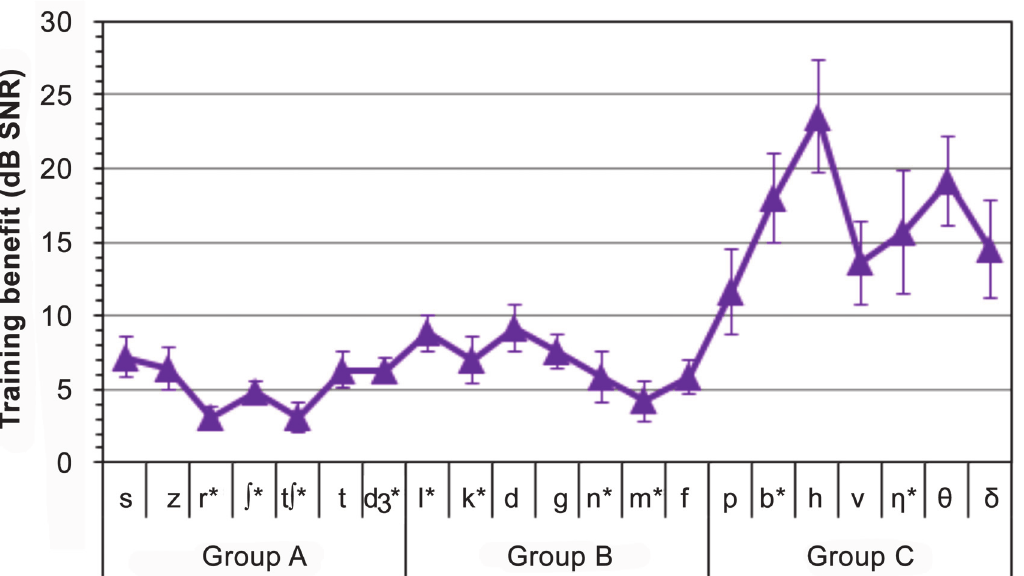
Fig 4. Training benefit on individual consonant identification thresholds. Measured in the laboratory before and after training. Error bars show standard errors. After training mean thresholds of consonants marked with asterisks were within the range seen in 16 ONH listeners.